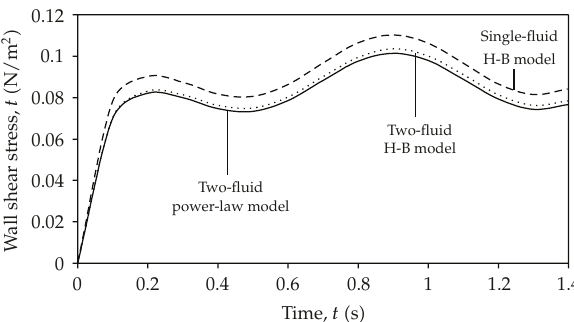
Figure 8: Variation of the wall shear stress with time at the middle of the stenosis for di ff erent fluid models with α (cid:7) 0.95, φ (cid:7) 0.1 ◦ , τ m (cid:7) 0.1 a , μ H (cid:7) 0.035, μ N (cid:7) 0.3 μ H , and τ y (cid:7)